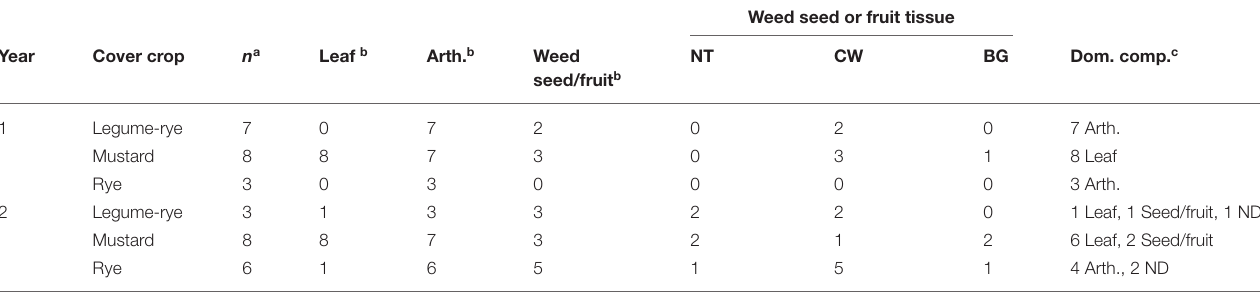
TABLE 2 | Composition of bird droppings in cover crops in Salinas, CA, USA during 2 years.